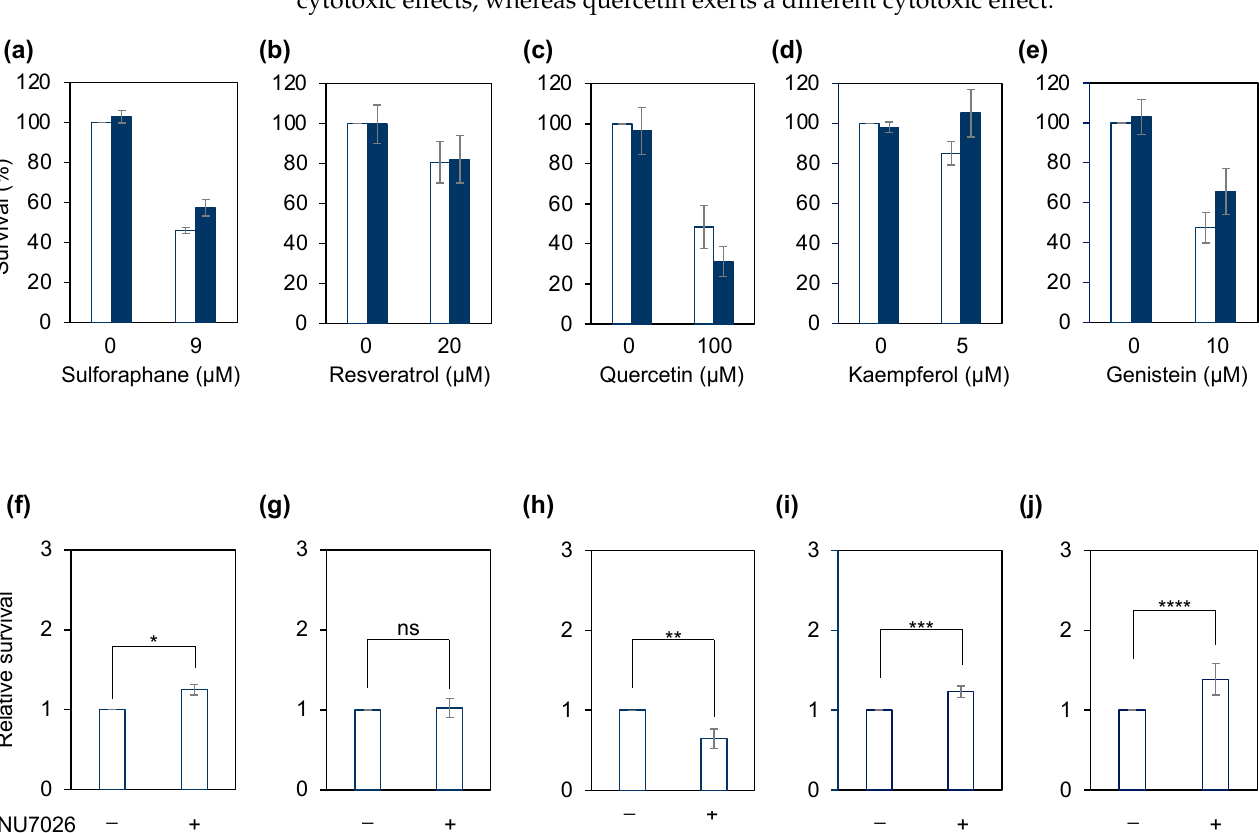
Figure 4. Sensitivity of HeLa cells to natural antioxidants with NU7026 pretreatment. HeLa cells were treated with or without NU7026 for 1 h and treated with sulforaphane ( a , f ), resveratrol ( b , g ), quercetin ( c , h ), kaempferol ( d , i ), or genistein ( e , j ). The resulting colonies were stained using crystal violet and counted. ( a – e ) The survival rate of HeLa cells treated with both NU7026 and natural antioxidants; the viability of the untreated cells is 100%. ( f – j ) Relative survival rate of HeLa cells treated with both NU7026 and natural antioxidants; the viability of the HeLa cells treated with natural antioxidants only is 1. Data represent the mean ± standard deviation of at least three independent experiments (Student’s t -test; * p = 0.0009, ** p = 0.0003, *** p = 0.005, **** p = 0.03, ns = no significant difference). Where absent, error bars fall within the symbols.